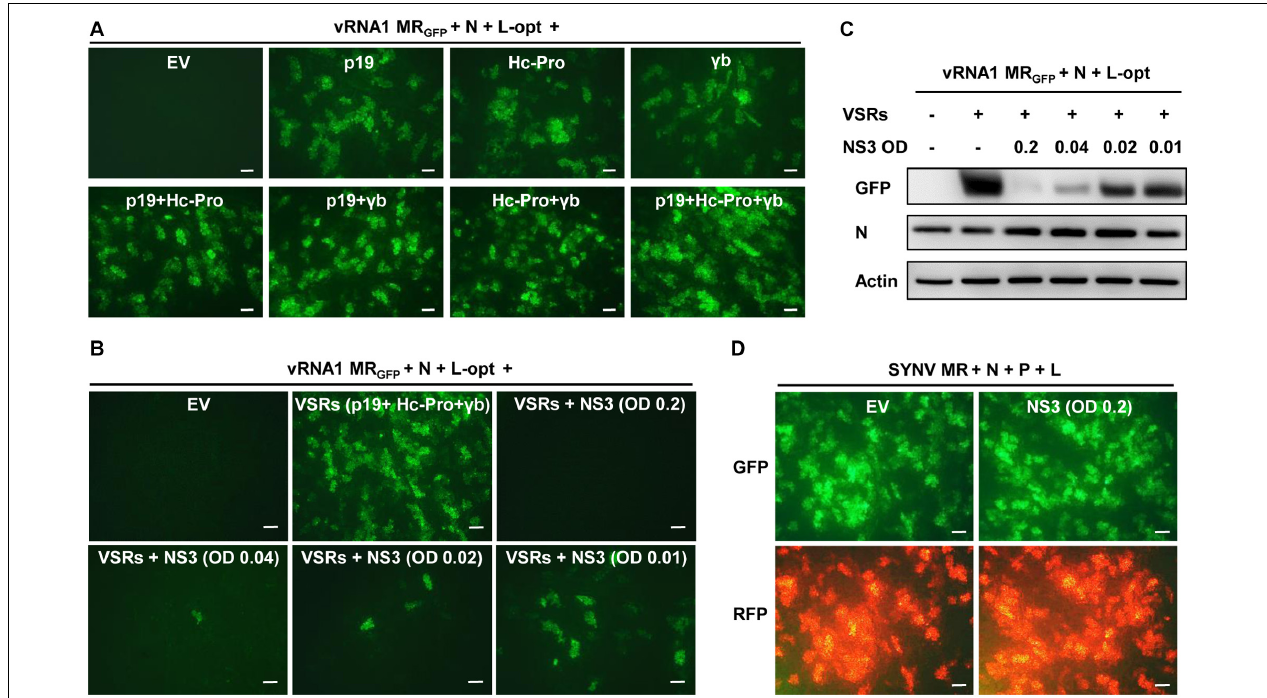
FIGURE 4 | NS3 inhibition of rice stripe virus (RSV) minireplicon (MR) activity. (A) Effects of the coexpressed individual and combinatorial heterologous viral suppressor of RNA silencing (VSRs) on RSV MR reporter gene expression. Appropriate volumes of different agrobacterial strains harboring the vRNA1 MR GFP plasmid, the N and L-opt expression plasmids, and either an empty binary vector (EV) or plasmids for expression of a single or multiple VSRs (p19, Hc-Pro, and γ b) were mixed to reach a final OD 600 of 0.2 for each strain. N. benthamiana leaves were infiltrated with the bacterial mixtures, and expression of green fluorescent protein (GFP) was photographed at 8 dpi with a fluorescence microscope. (B,C) Dose-dependent inhibition of RSV MR activity by NS3 protein. Agrobacterial strains harboring the NS3 expression plasmid or an empty vector (EV) was added into the above MR mixtures containing all three VSRs (p19 + Hc-Pro + γ b) at a final OD 600 of 0.2, 0.04, 0.02, or 0.01. (B) GFP foci in agroinfiltrated N. benthamiana leaves were imaged at 8 dpi and (C) expression of GFP and N proteins in these leaf tissues were detected by Western blotting with anti-GFP and anti-N antibodies. Detection with an anti-Actin antibody was used as a protein loading control. (D) Lack of inhibitory effect of NS3 on Sonchus yellow net virus (SYNV) MR activity. SYNV MR assays were carried out by agroinfiltration of N. benthamiana leaves to express SYNV MR GFP − RFP , the SYNV N, P, and L proteins, VSRs, and an EV control or RSV NS3. The final concentrations of each bacterial strain were adjusted to OD 600 0.2. Expression of reporter genes was monitored at 7 dpi under the GFP channel (upper) and RFP channel (bottom). Scale bar = 200 µ m in (A,B,D) .